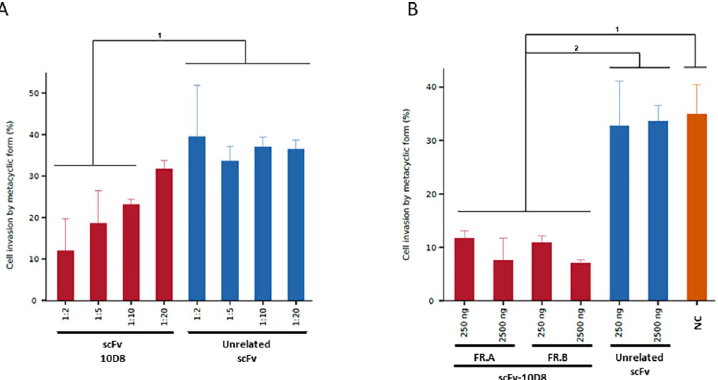
Fig 4. Effect of pre-incubation of metacyclic trypomastigotes (MTs) with scFv-10D8 on LLC-MK2 cell invasion. a MTs of T . cruzi G strain were pre-incubated with different dilutions of periplasmic fractions containing sFv-10D8 or an unrelated scFv for 2 h. b MTs of T . cruzi G strain were pre-incubated with different concentrations (250 and 2500 ng) for both purified protein fractions (scFv-10D8) and unrelated scFv (scFv Loxo) for 2 h and a negative control (NC, without antibody presence). FR.A and FR.B correspond to two independent fractions enriched for scFv-10D8. Statistically significant differences are represented by letters above the graph bar. The parasites were washed and incubated with LLC-MK2 cells at MOI 100:1. The percentage of infected cells was determined by the mean of blind counts of 300 cells from three independent experiments. The main statistically significant differences are indicated by horizontal bars above the columns (p �